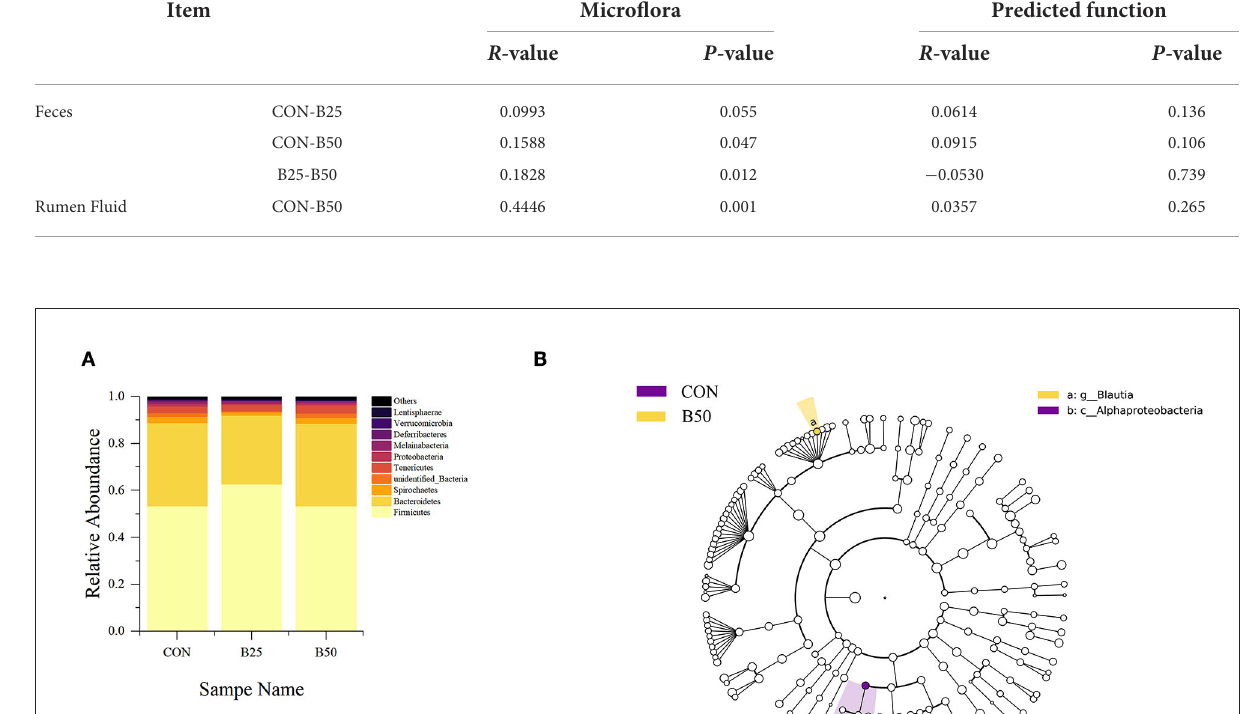
the relative abundance of Bacteroidetes had decreased in B50 ( p < 0.05). At the genus level, the dominant bacteria